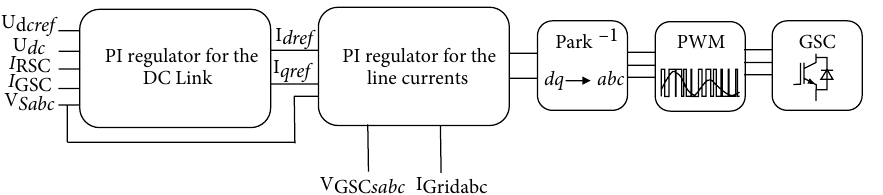
Figure 8: Control scheme of the GSC using the PI regulators.